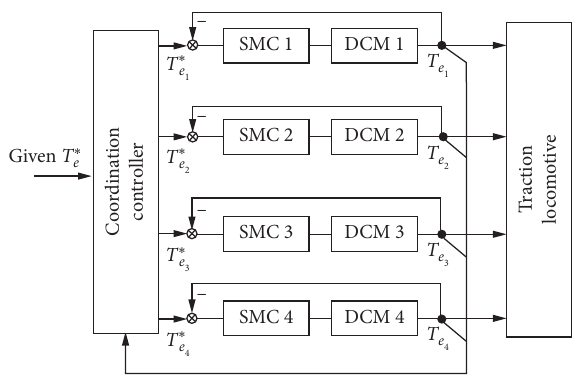
Figure 1: Multimotors coordination control strategy for consistent total traction